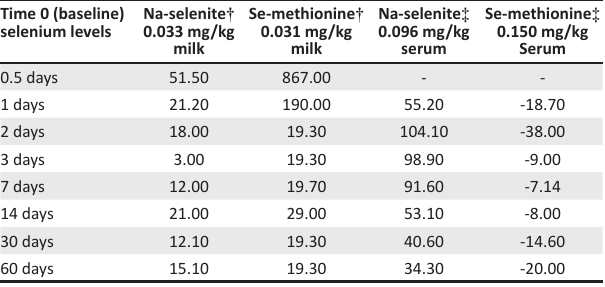
milk and serum selenium concentrations post injection of Na-selenite and